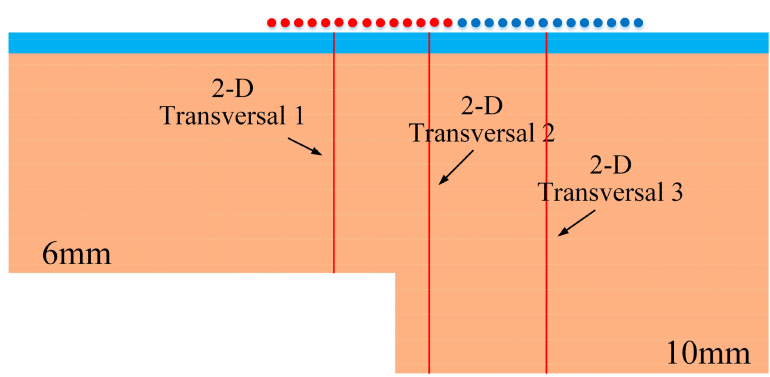
Figure 6. Schematic diagram of 2D transversal